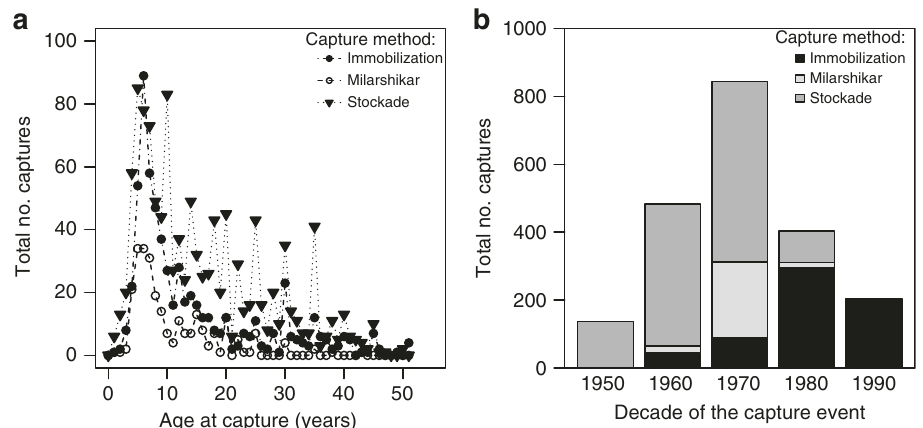
Fig. 3 Capture frequencies by elephant age at capture and time period differentiating the three capture methods. a The number of 1 to 51-year-old elephants (males and females combined) captured by the immobilization, milarshikar and stockade methods. b The number of captured elephants in our dataset 1951 – 2000 by the immobilization, milarshikar and stockade methods. The cohort "1990" includes also 3 elephants captured by immobilization in 2000. N =